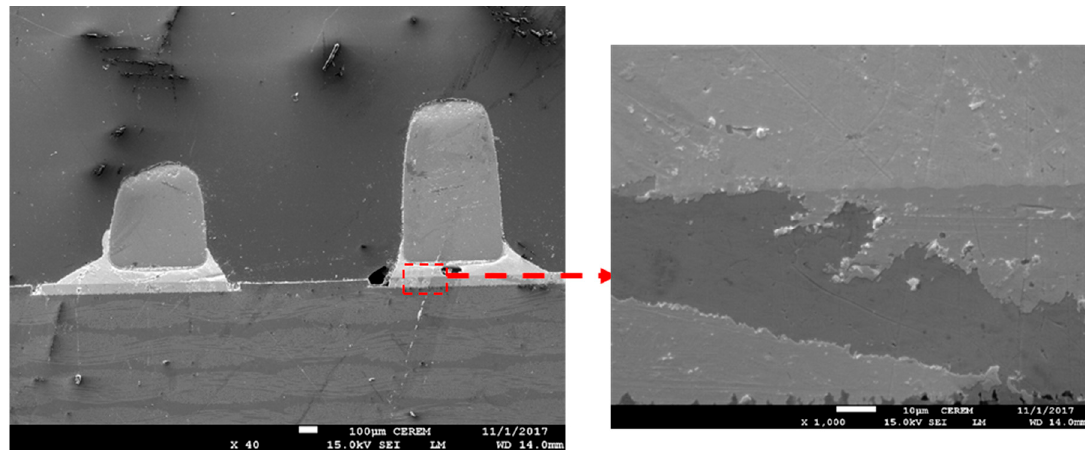
Figure 8. SEM micrograph for the joint interface of a passive component with water washable solder paste.